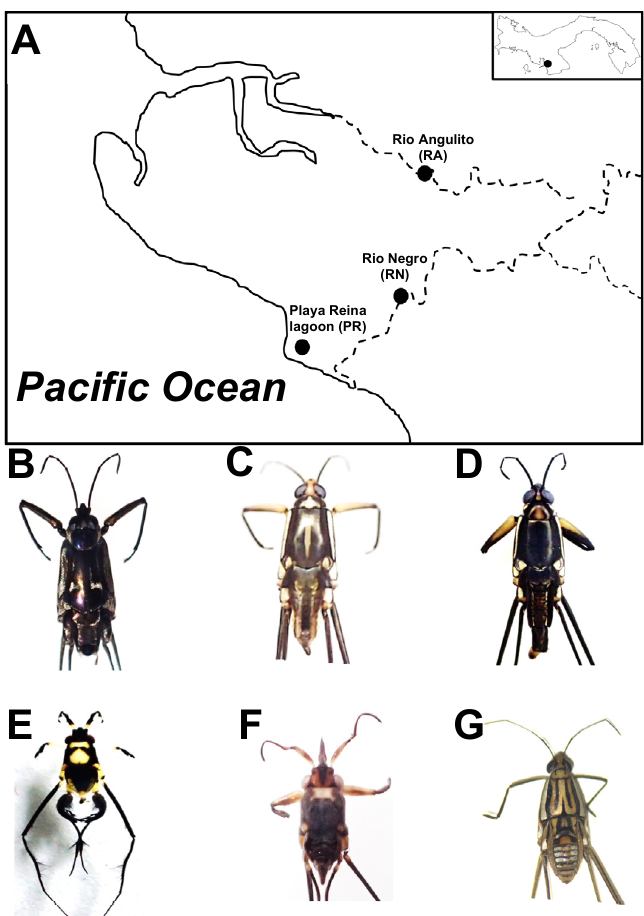
Figure 1. Sampling sites ( A ) and water striders species Platygerris assimetricus (Hungerford, 1932; B ), Potamobates horvathi (Esaki, 1926; C ), Potamobates tridentatus (Esaki, 1926, D ), Rheumatobates bergrothi (Meinert, 1895; E ), Rheumatobates ornatus (Polhemus and Cheng, 1976; F ), Telmatometra withei (Bergroth, 1908; G ). Photo credits: Pamela Polanco and Anakena Castillo. Table 1. Number of individuals of six water strider species sampled at three sites on the Western Azuero Peninsula, Panama.